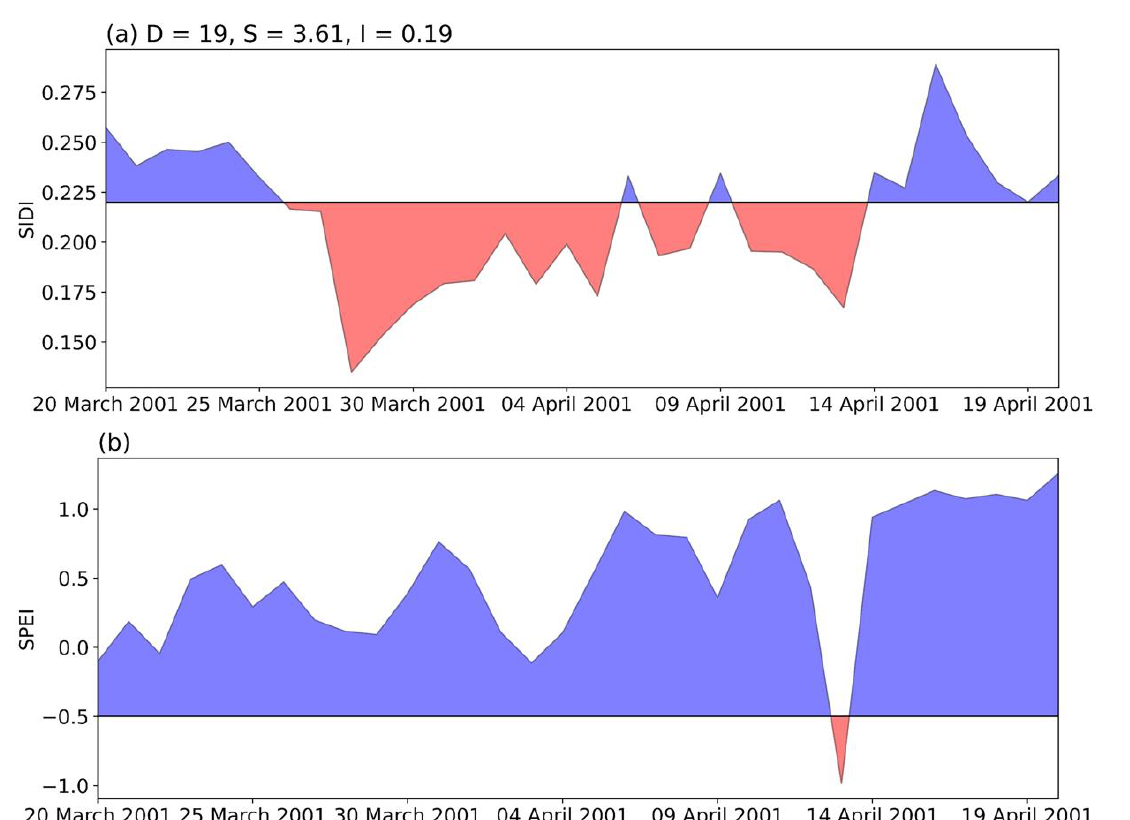
Figure 8. Daily drought evolution of a drought event identified by the SIDI ( a ) and SPEI ( b ) at the BJ station based on run theory. D: drought duration; S: drought severity, which is the cumulative sum of drought conditions on D days; I: drought intensity, which can be calculated by dividing S by D. Red patterns represent dry conditions, and blue patterns represent wet conditions.